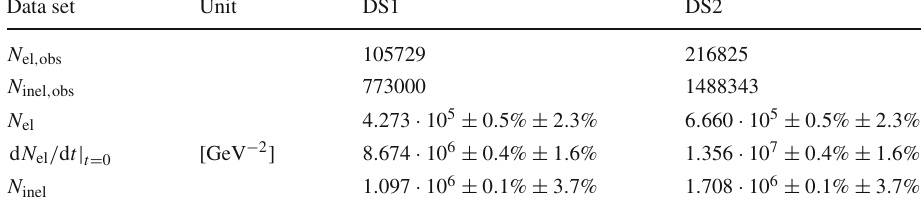
el , obs and inelastic rate N inel , obs , the fully corrected elastic N el and inelastic rate N inel and the optical point d N el / d t | t = 0 of the two data sets (errors where quoted are statistical and